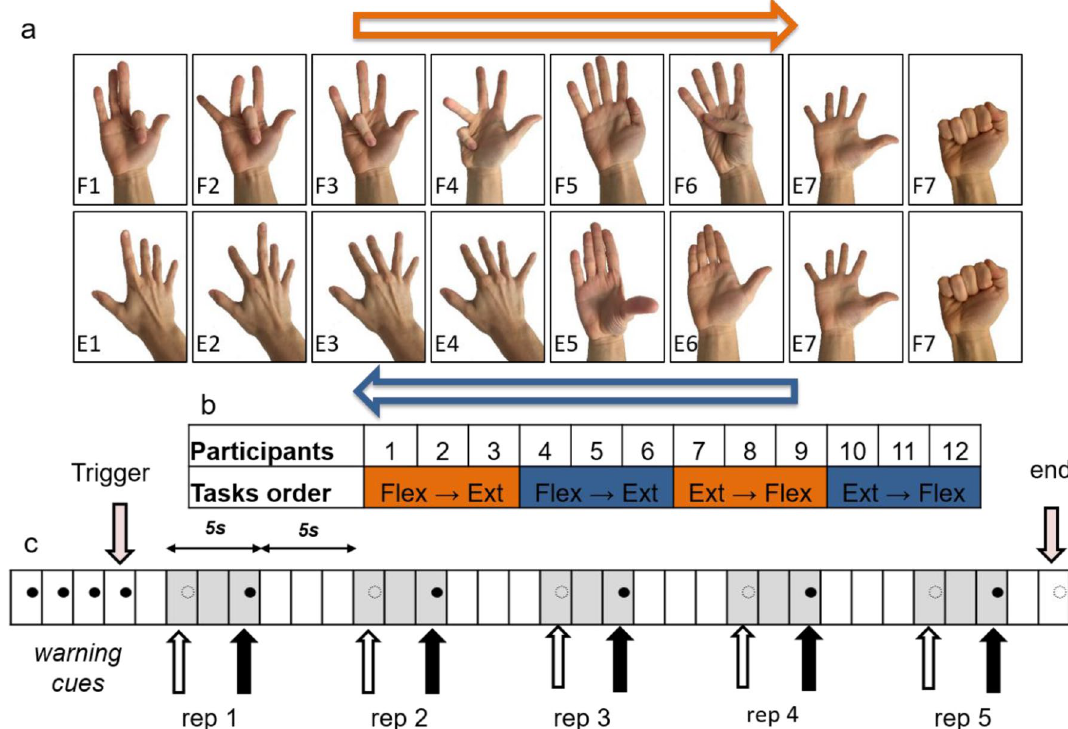
Figure 6. 16 gestures performed by the 12 participants, randomization of their performance and structure of each acquisition of each gesture. The last two gestures in each row are the same and have been used as control movements. ( a ) Visual description of the gestures and of their execution order (depending on the subject group). To each gesture, it has been assigned a univocal code composed by a letter (F for flexion and E for Extension) and a progressive number. ( b ) Table identifying the muscle group and task execution order for each participant. ( c ) schematic of the acquisition performance for each gesture. Figure created with Microsoft PowerPoint